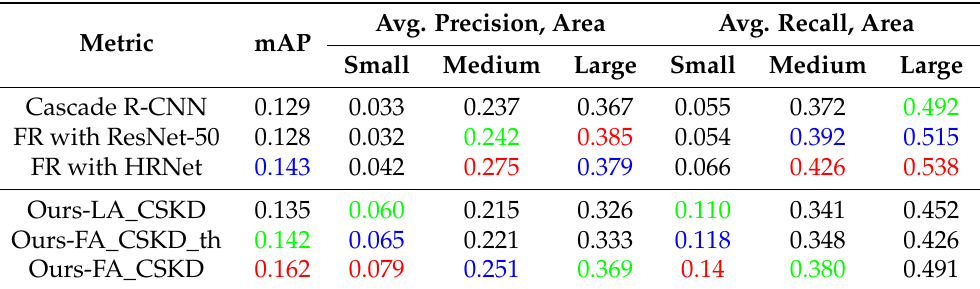
Table 8. Further comparison with 3 methods in VisDrone-DET2019. The top three methods are highlighted in red, blue, and